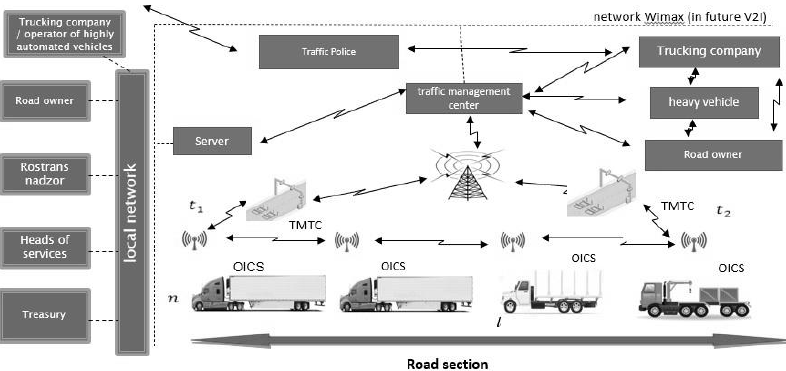
Figure 4. Model for the construction of the TASWC HGV .